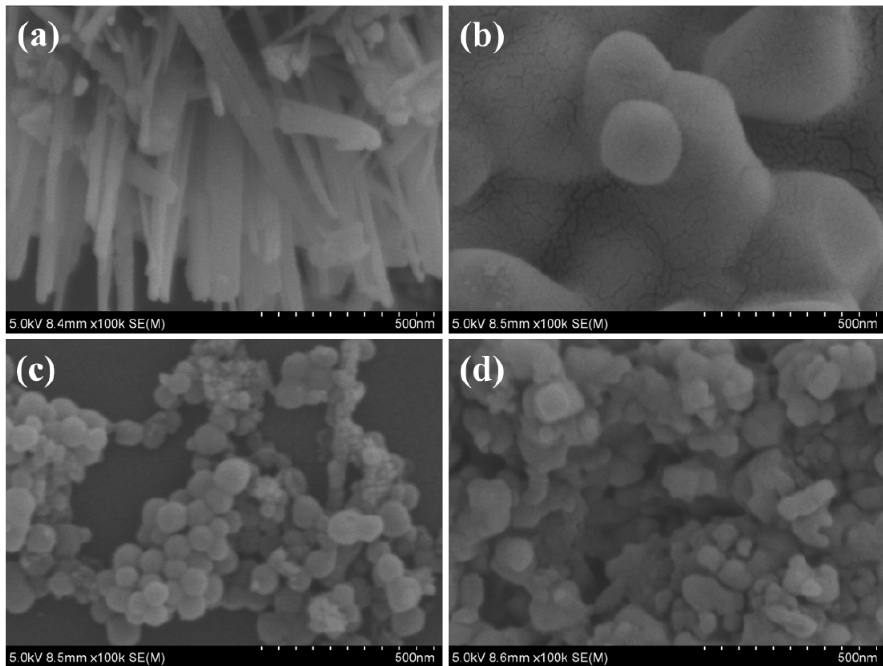
◦ C; ( c ) ZIF-8@ γ -MnO